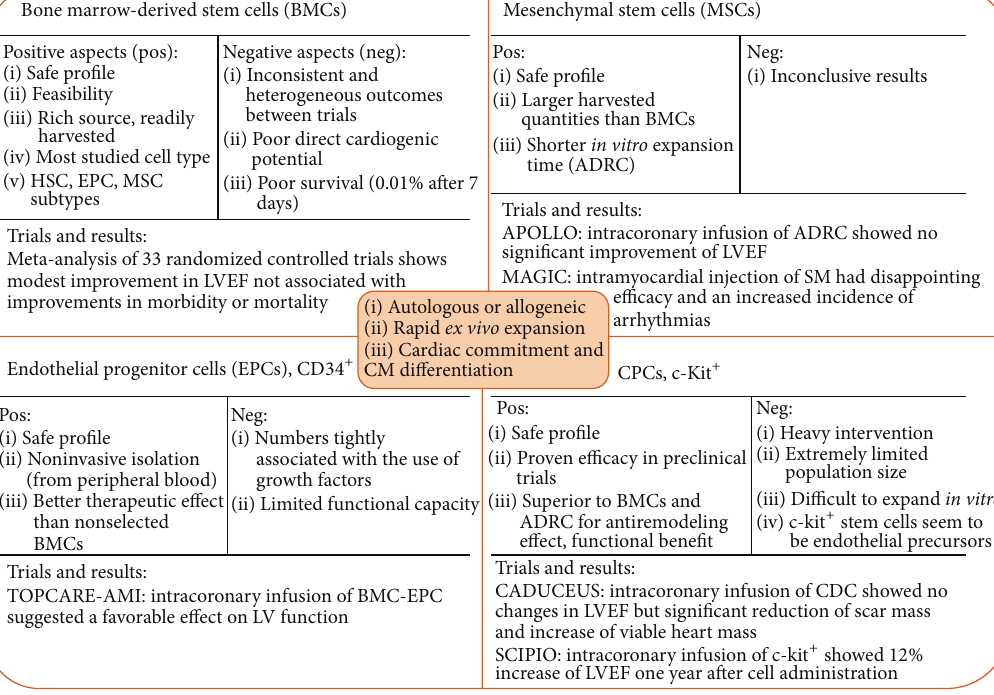
Figure 2: Current state of stem cell therapy for acute myocardial infarction in clinical trials. The optimal cell population for cardiac regenerativecelltherapiesrequiresautologousorallogeneicorigin,rapid exvivo expansion,andcardiaccommitmentincludingdifferentiation to cardiomyocytes. Numerous clinical trials have been undertaken with moderate results (for reviews see [8, 77, 172–174]). ADRC: adipose- derived stem cells; BMC: bone marrow cells; CDC: cardiosphere-derived cells; CM: cardiomyocytes; EPC: endothelial progenitor cells; HSC: hematopoietic stem cells; LVEF: left ventricular ejection fraction; MSC: mesenchymal stem cells; SC: stem